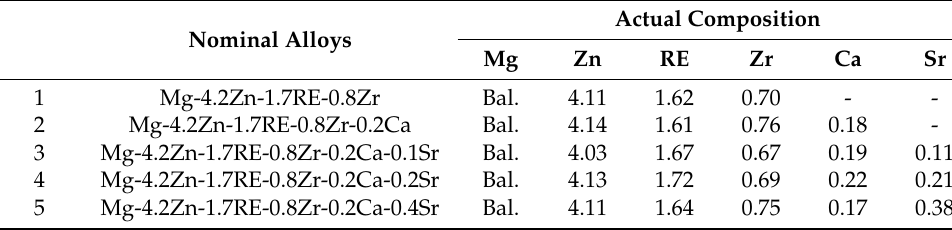
Table 1. Chemical compositions of the as-cast alloys (wt.%).